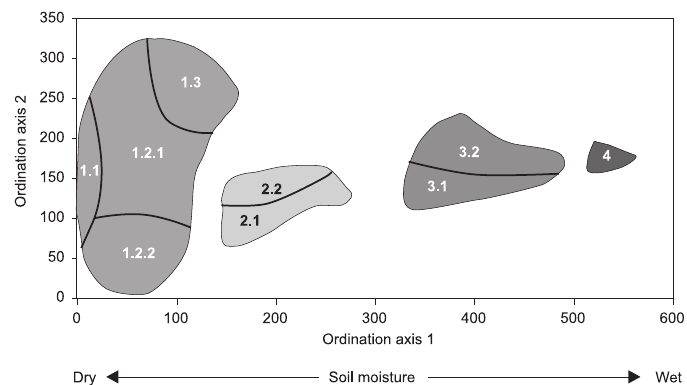
Fig. 2. The relative positions of the communities and sub-communities along the first two axes of the ordination of the relevés sampled in the Vhembe-Dongola National Park on the Ia land